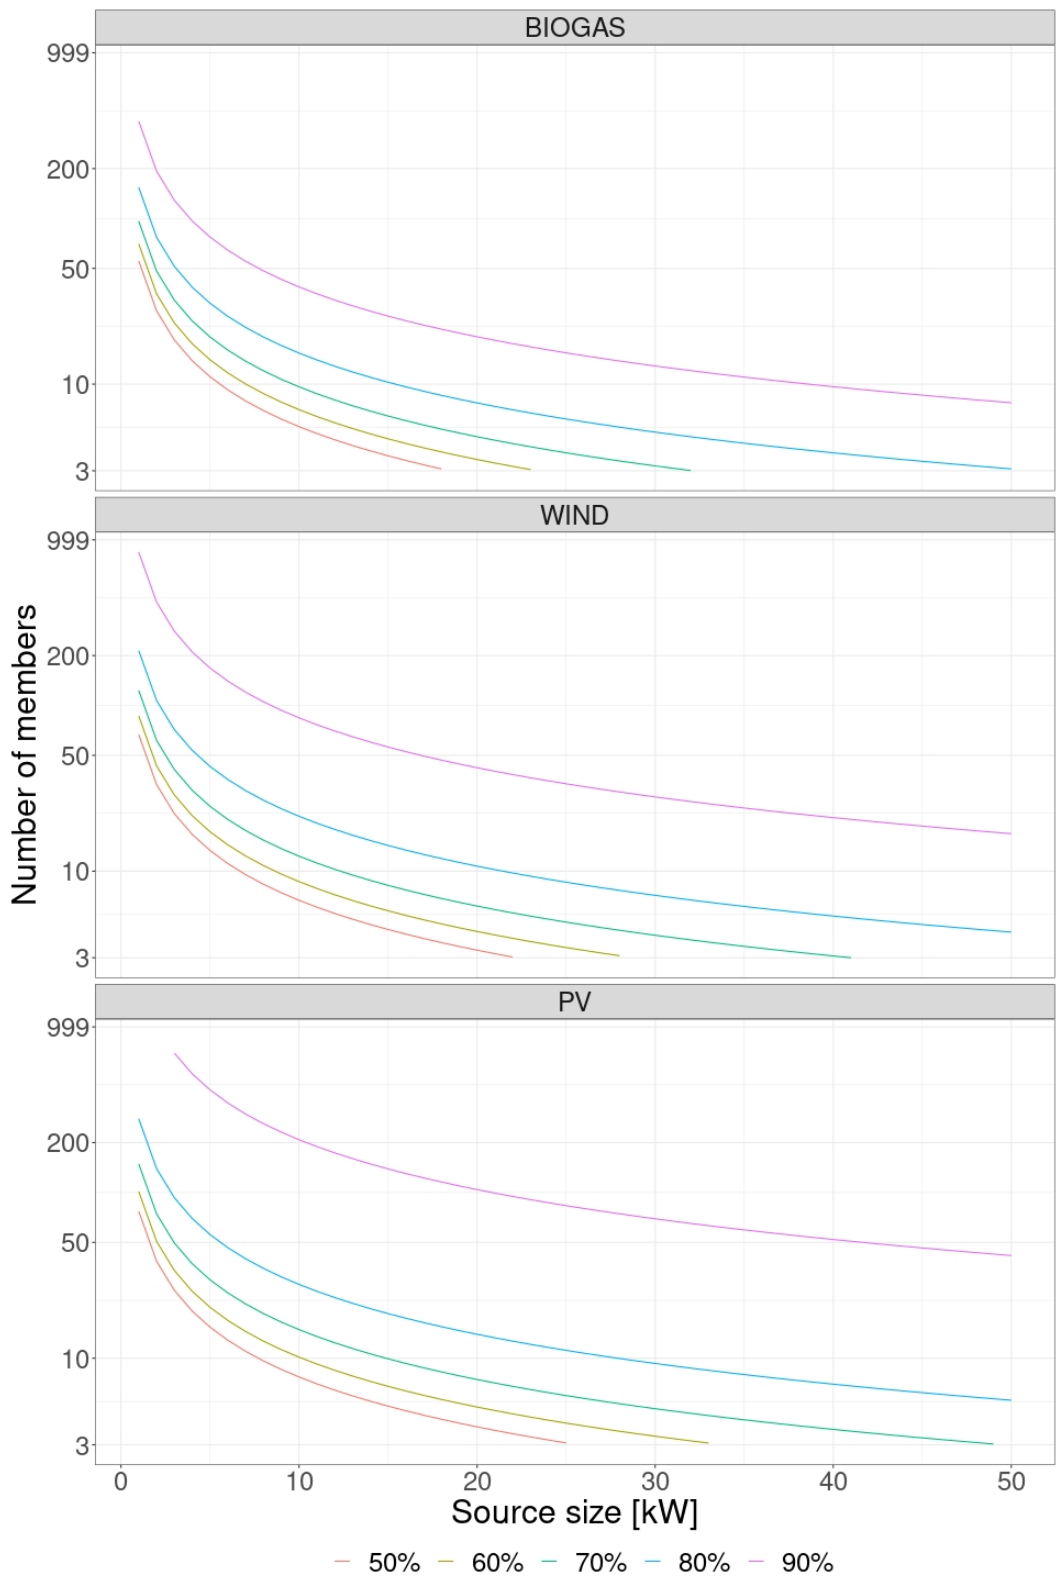
Figure 10. Number of members of an energy cooperative and source size that covers the energy demand and the operation of one cryptocurrency